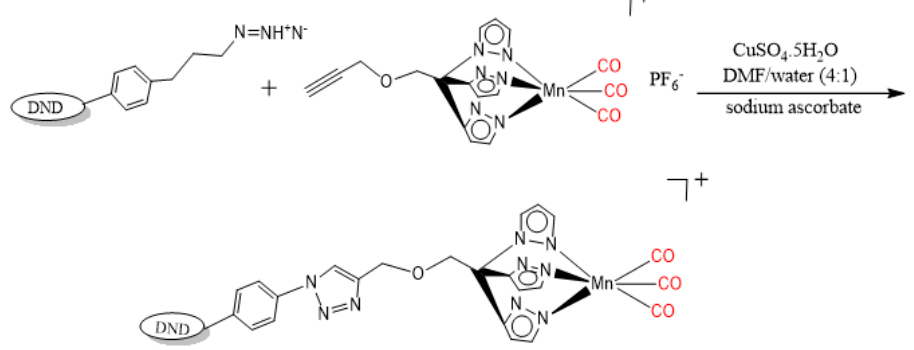
Figure 27. The [Mn(CO) 3 (tpm)] + -functionalized nanodiamond (ND) immobilized on azidemodified ND’surface through CuAAC “click”